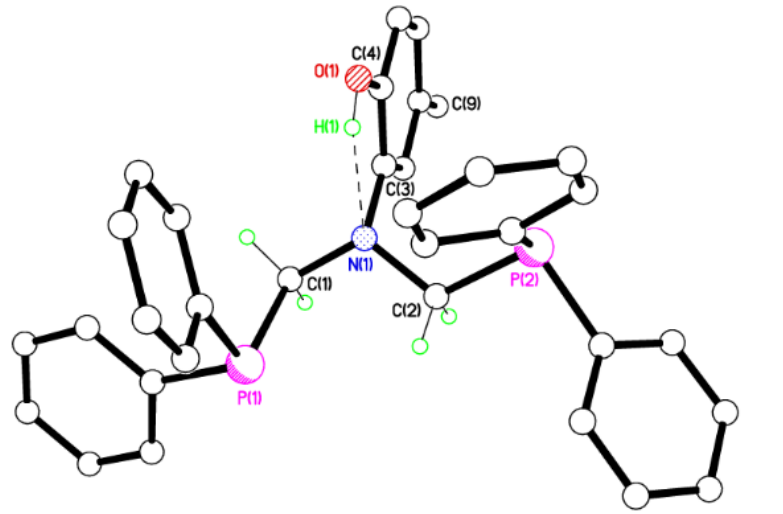
Figure 1. Molecular structure of 1a . All hydrogens, except on C(1), C(2) and O(1), have been omitted for clarity. Table 3. Selected data ( D ∙∙∙ A /Å, ∠ D –H ∙∙∙ A /°) for key inter- and intramolecular contacts for com-